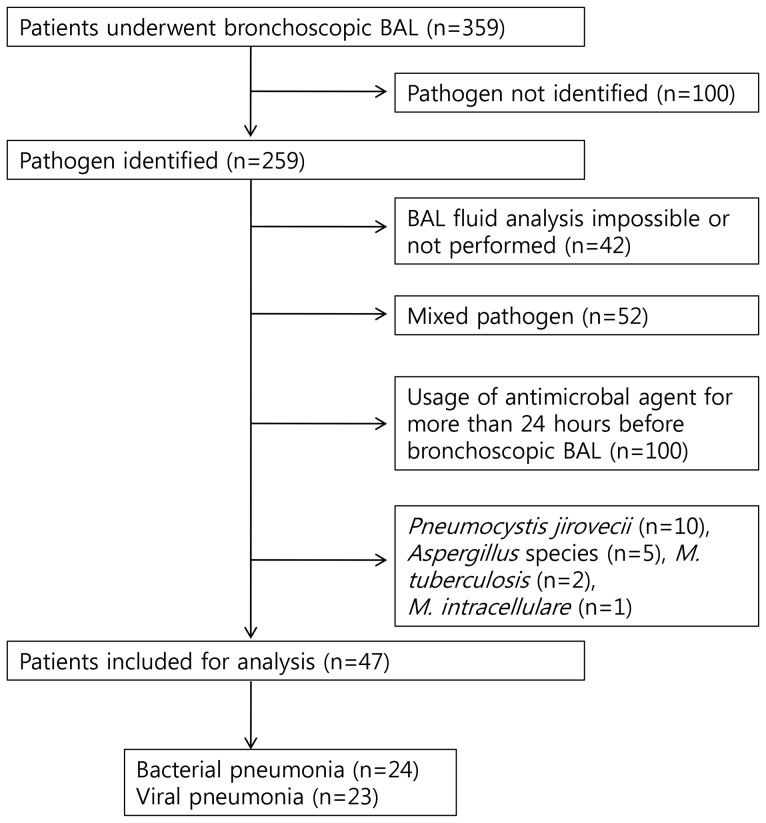
Enrollment process for patients admitted to the medical intensive care unit due to pneumonia, with reasons for exclusion.